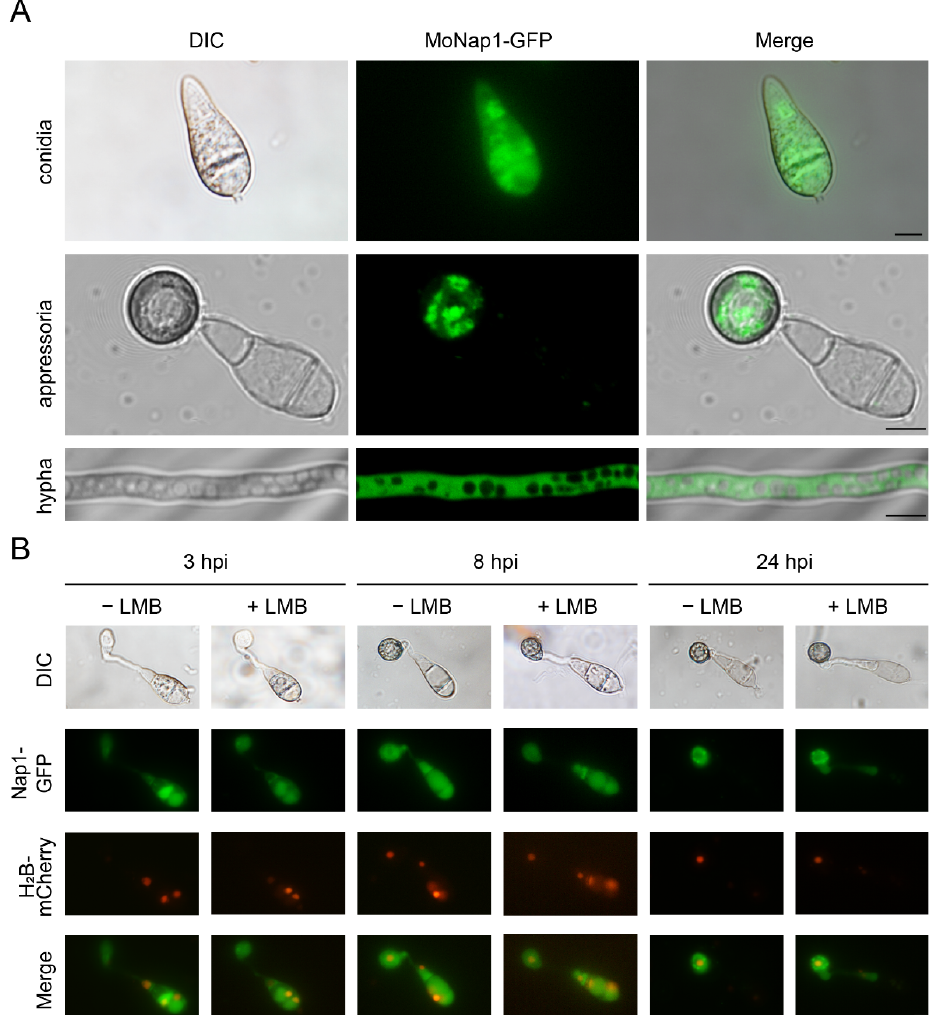
Figure 9. Subcellular localization of MoNap1 in M. oryzae . ( A ) Fluorescence signals of MoNap1-GFP in conidial, appressorial and hyphal cells. Bar, 5 μ m. ( B ) Fluorescence signals of MoNap1-GFP and H 2 B-mCherry under LMB treatment in conidia and appressoria. Bar, 5 μ m.